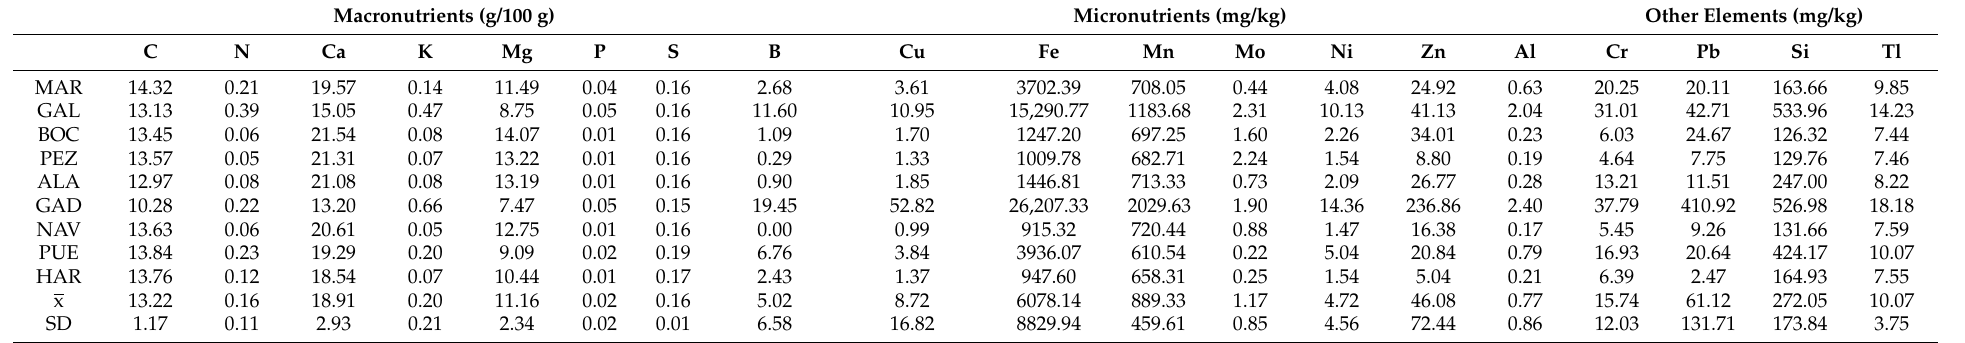
Table 2. Average values of macronutrients (g/100 g), micronutrients (mg/kg) and other elements of interest (mg/kg) concentrations obtained for soil samples, total averages (x) and their standard deviations (SD) for each element.